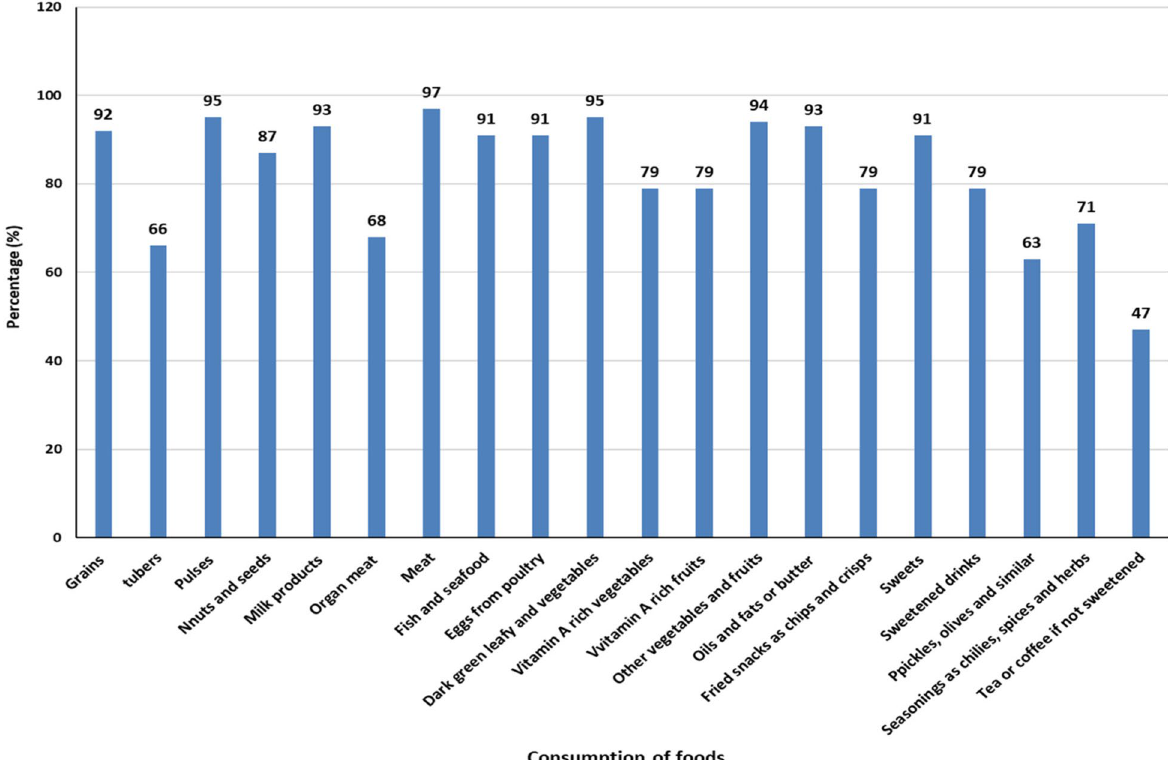
Fig. 1 Percentage of consumption of different food items among